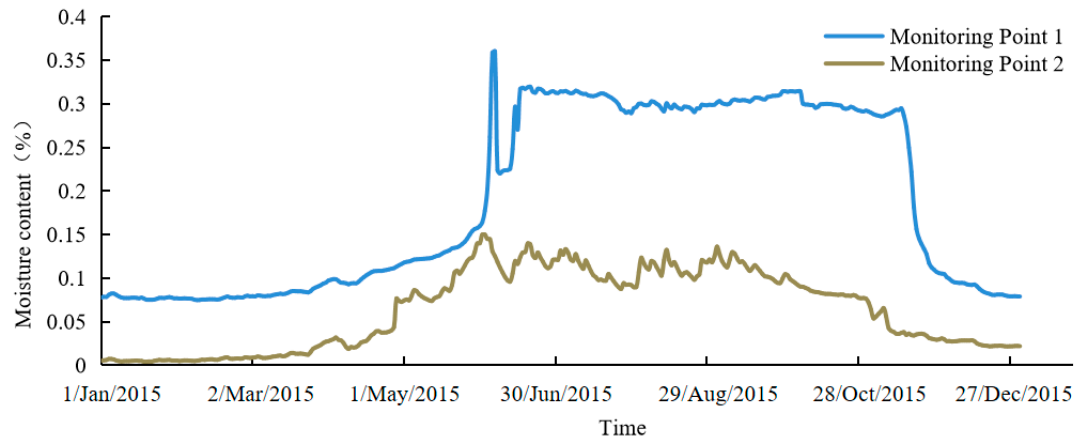
Figure 5. Variation of surface moisture content (30 cm) under different cover conditions.